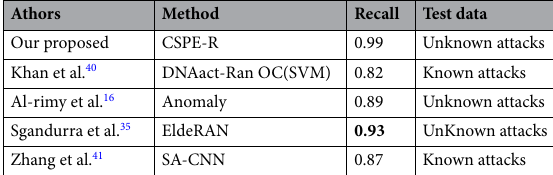
Table 5. Comparison with current techniques. Significant values are in [bold].